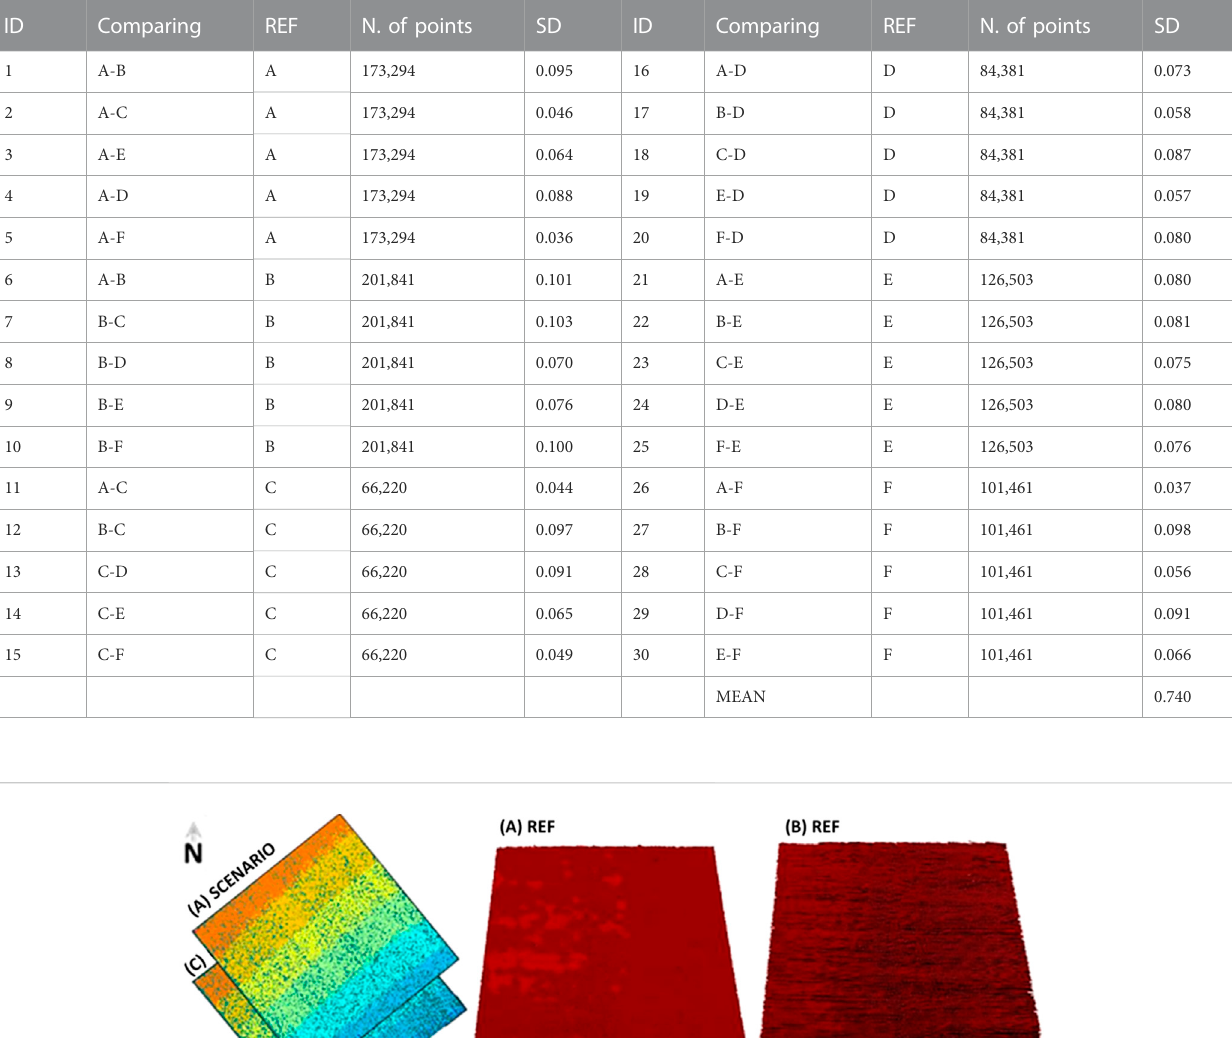
TABLE 1 Summary of the distance between the MBES dense clouds of six interval measurements.